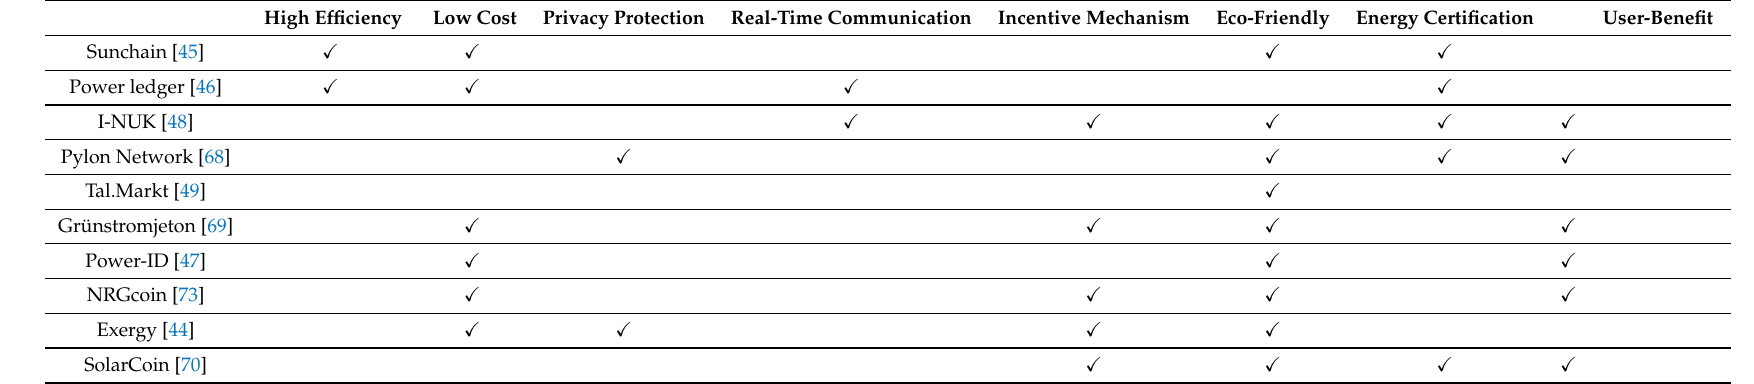
Table 2. Energy project